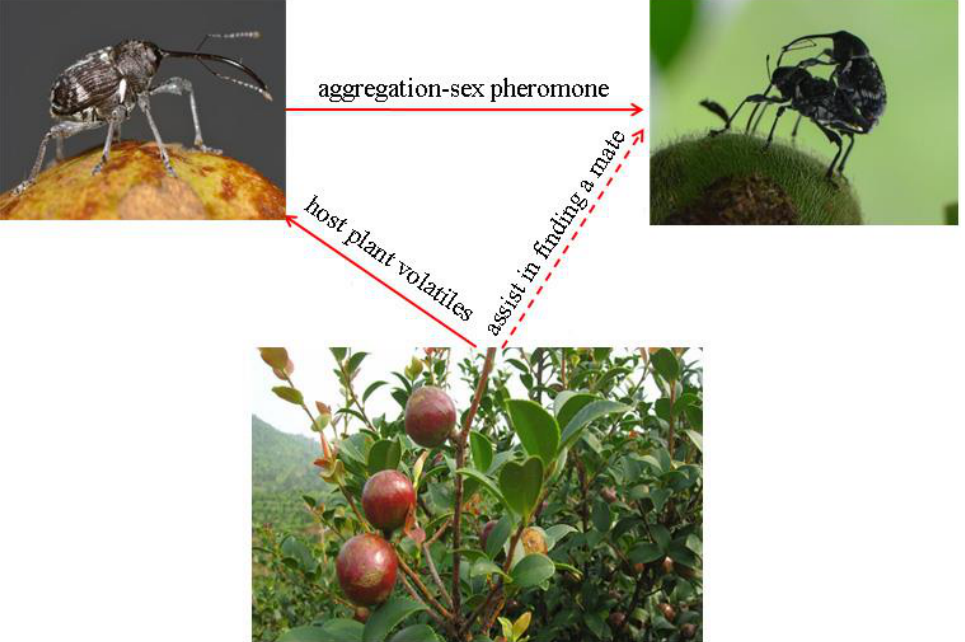
Figure 1. The schematic diagram of adult Curculio chinensis beetles locating a mate and feeding on fruit using host plant odors and their aggregation pheromone.